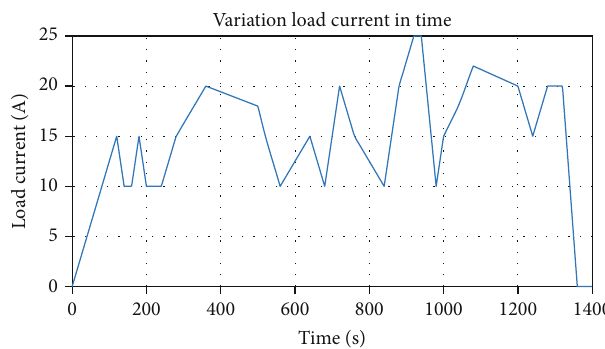
Figure 14: Load pro fi le used in numerical simulations — case II.